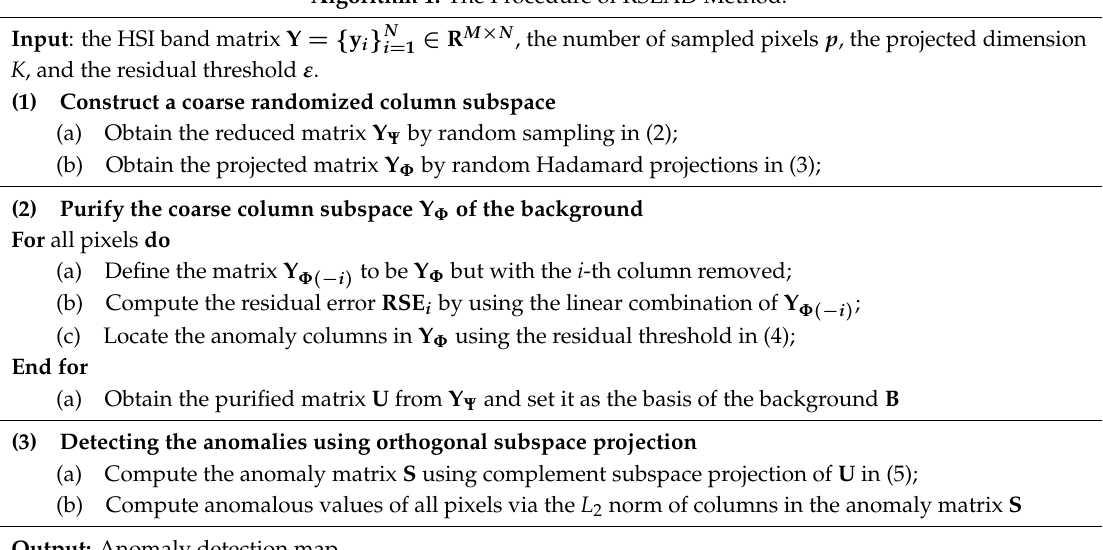
Figure 2. The sketch map of RSLAD for anomaly detection. Algorithm 1. The Procedure of RSLAD